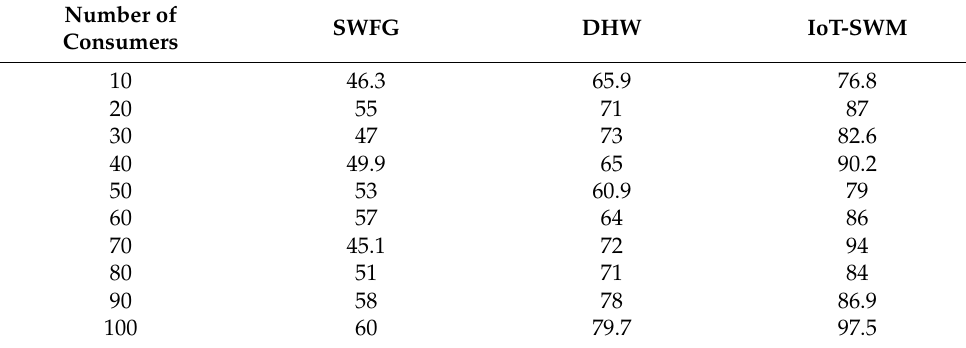
Table 4. Leakage detection